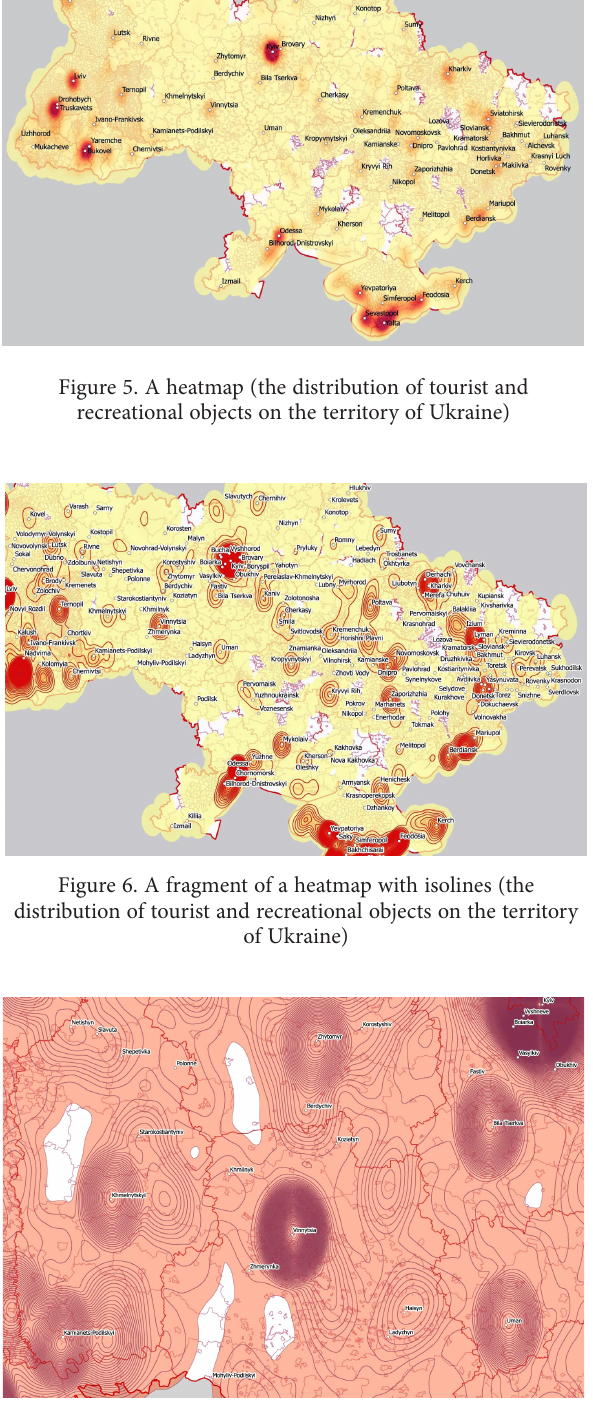
Figure 7. A fragment of a heatmap with white